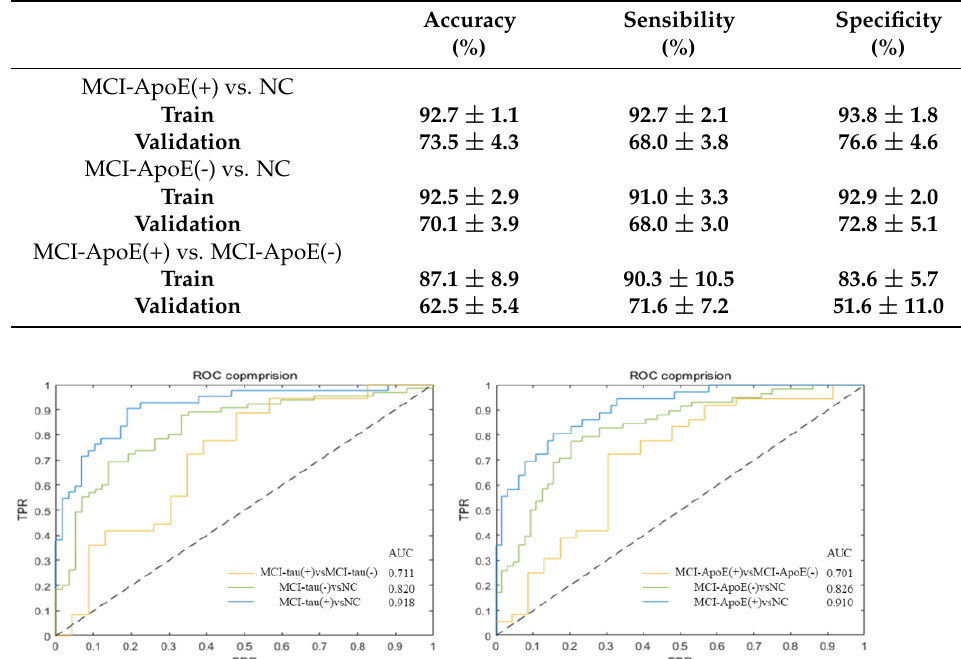
Table 5. The classification results for MCI-ApoE subgroups.